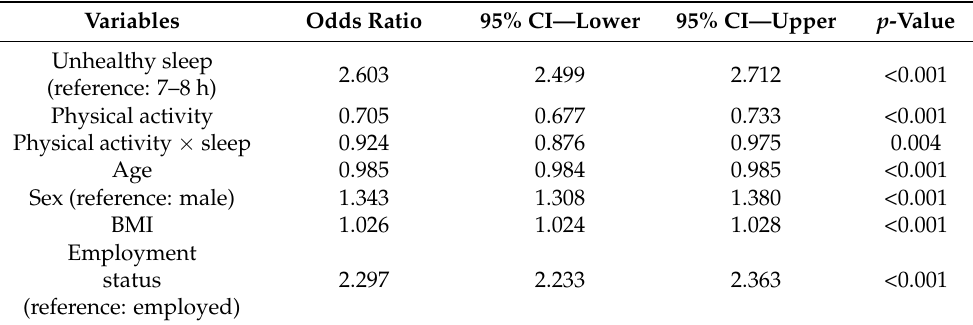
Table 6. The moderating effect of physical activity on the relationship between healthy sleep and emotional distress predictions among Whites ( n =